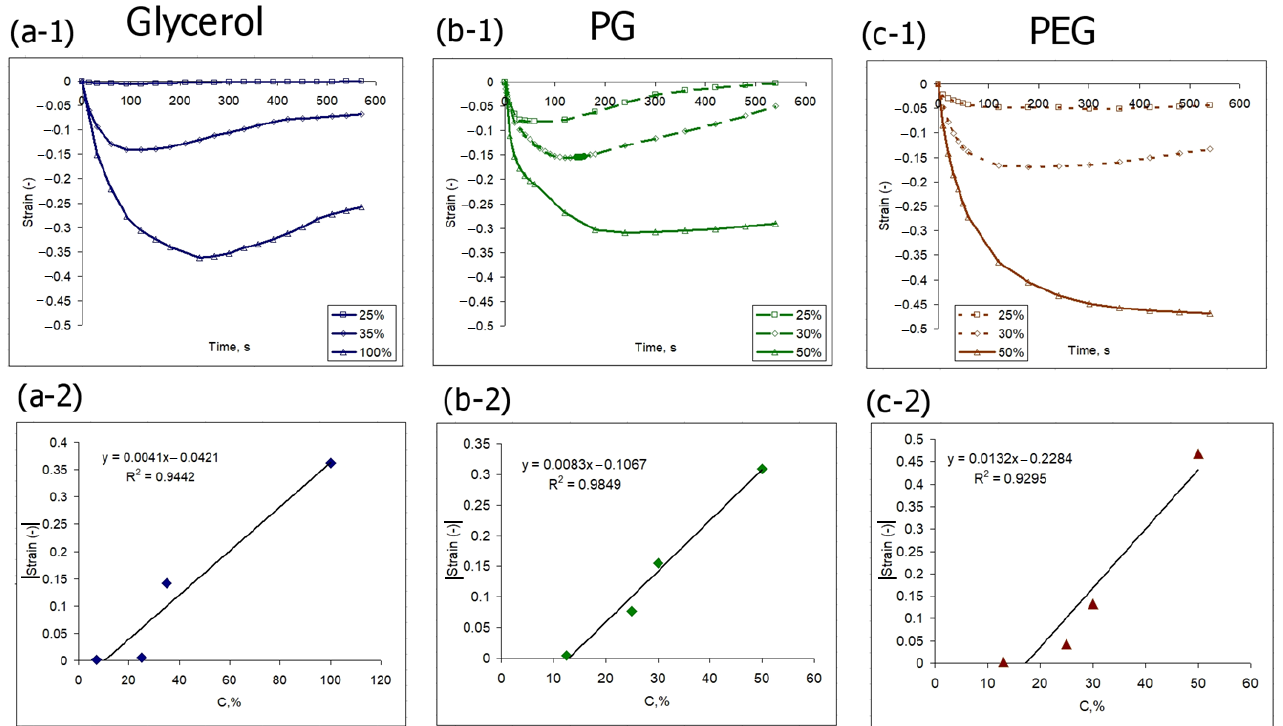
Figure 7. Quantitative analysis of negative ‐ signed strain kinetics induced in cartilage by the action of ( a ) glycerol, ( b ) PG and ( c ) PEG ‐ 400 with various concentrations. The upper images show the kinetic curves of strain evolution. The lower images show the corresponding dependencies of strain minima on the agent concentration.